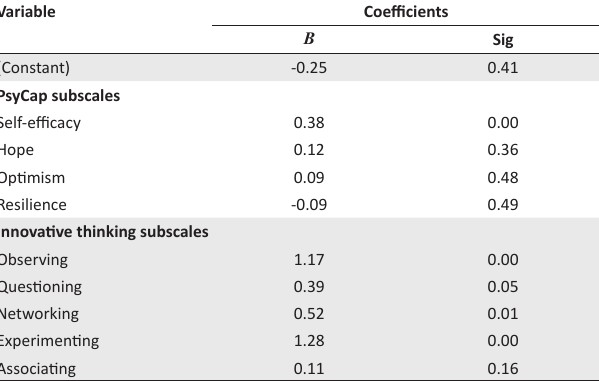
TABLE 7b: Psychological capital subscales and innovative thinking subscales combined